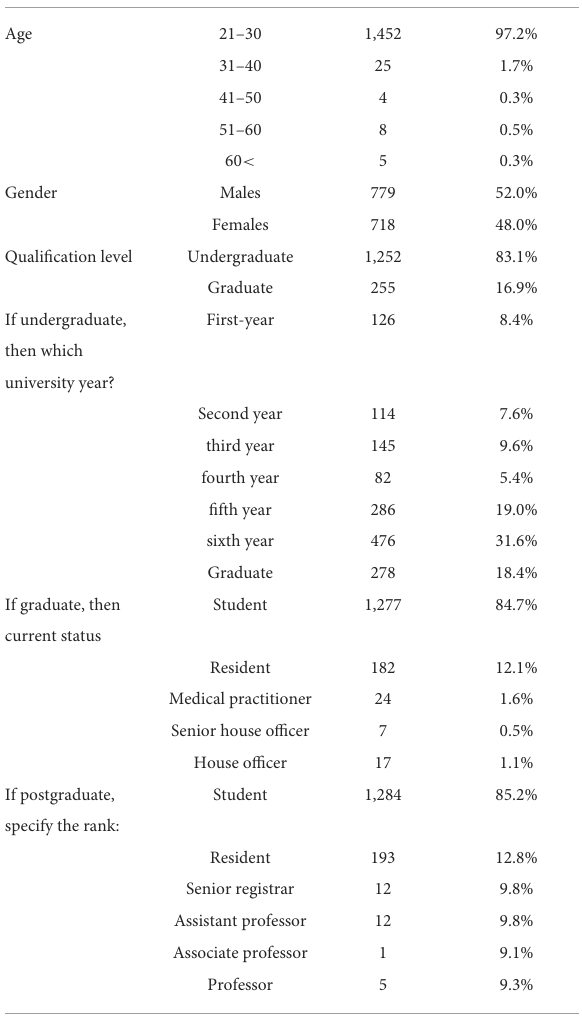
TABLE 1 Baseline characteristics of the study